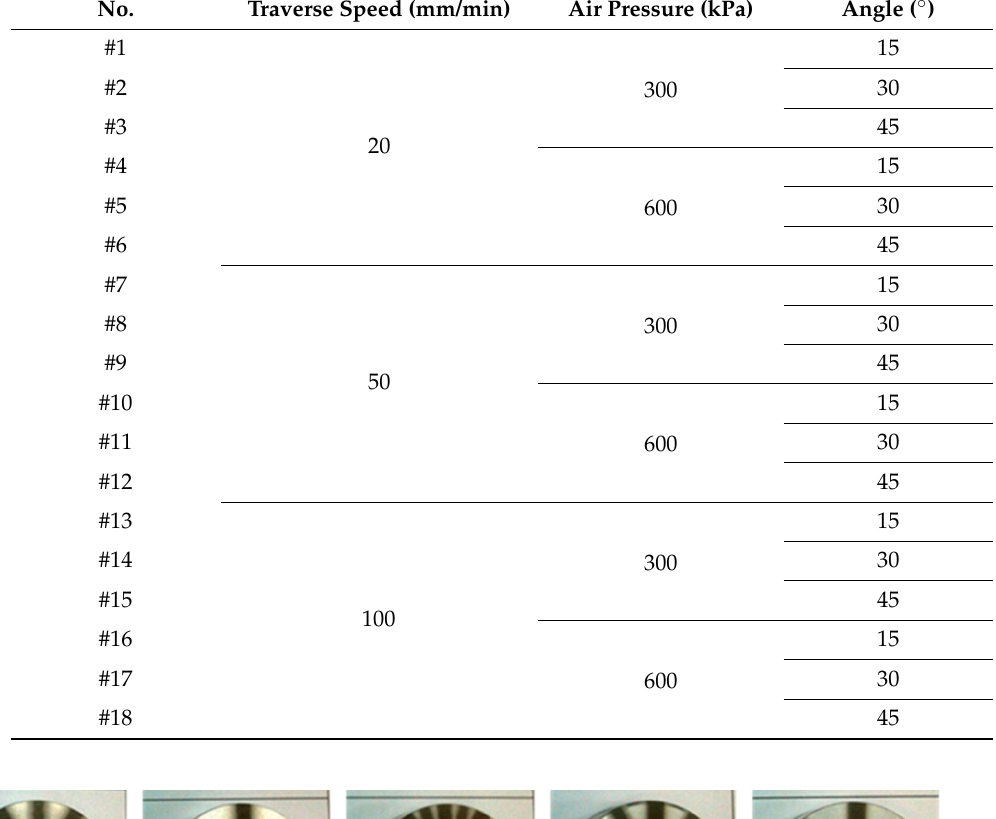
Table 1. Micro-AAJ machining conditions.